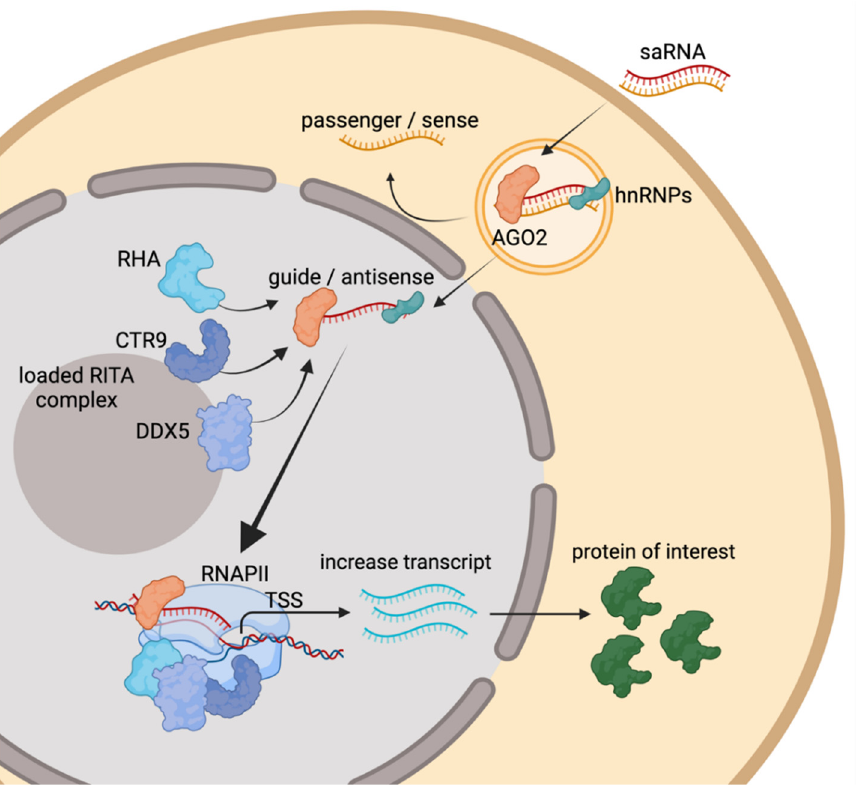
Figure 1. Molecular pathway for RNA activation. saRNA enters the cell and interacts with AGO2 (Argonaute 2) and hnRNPs in the cytoplasm The dsRNA is unwound, and the sense strand is displaced. The RNA-protein complex enters the nucleus and interacts with RHA and CTR9, forming the RITA complex. RITA activates the transcription of the target gene leading to an increase in target transcript and protein of interest. TSS—transcription start site.